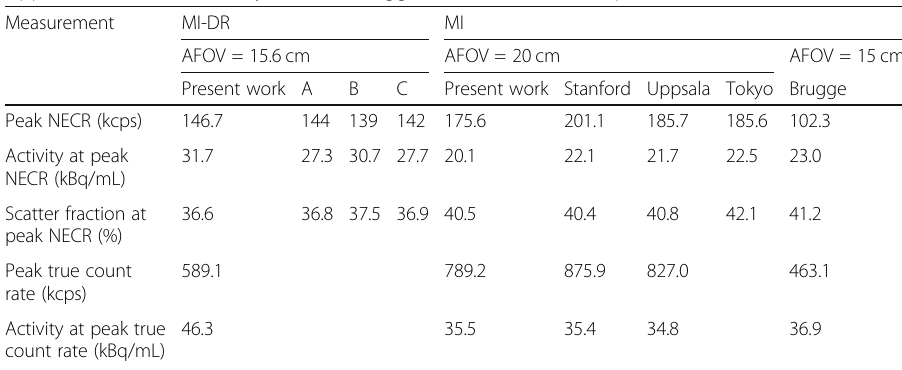
Table 2 Peak noise equivalent count rate (NECR), scatter fraction, peak true count rate and their corresponding activity concentration for the DMI-DR and DMI systems. Results obtained for DMI- DR at Southampton, Poole, and Plymouth (scanners A, B, C) [5] and for DMI at Stanford and Uppsala Universities [2], Tokyo [3] and Brugge [4] are listed for comparison